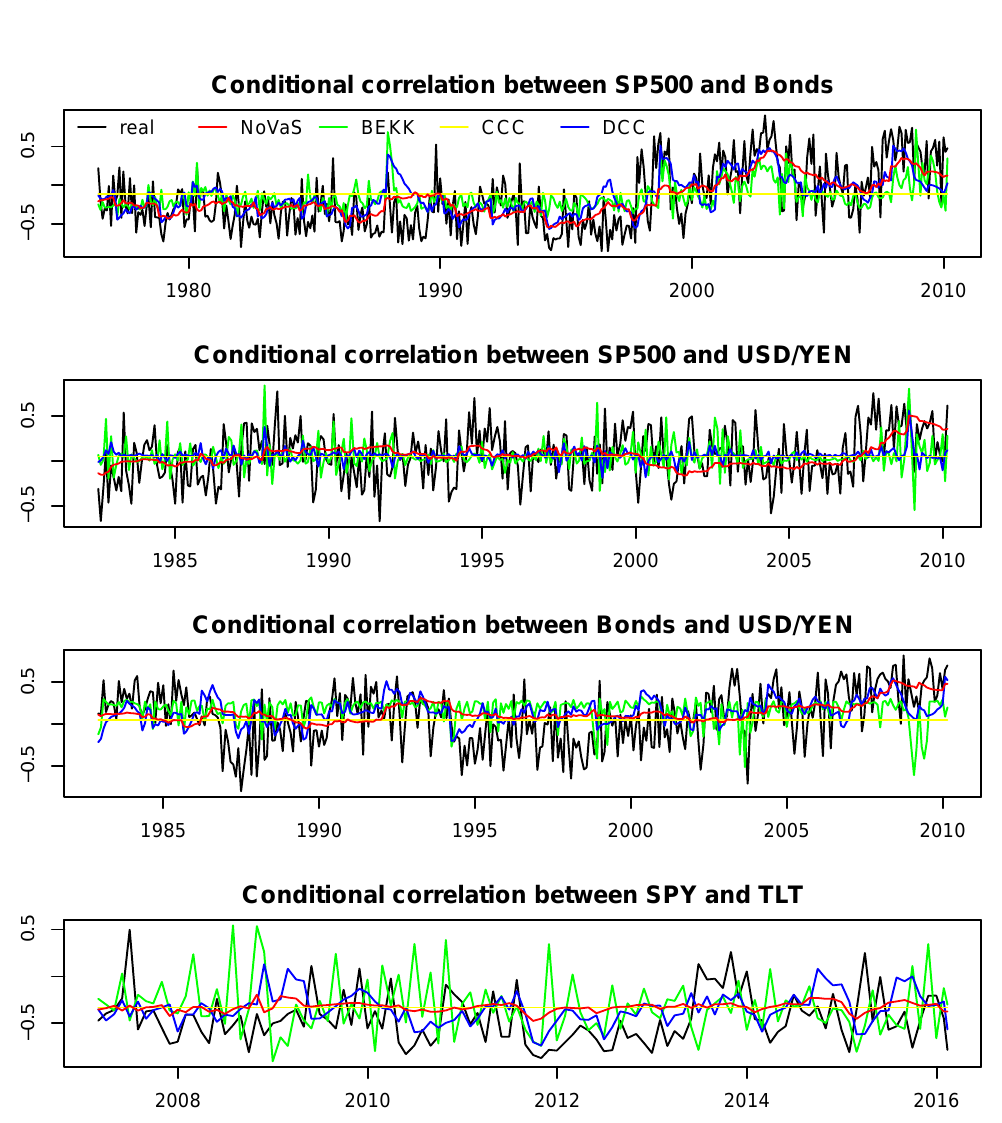
Figure 2. Monthly realized correlations and fitted